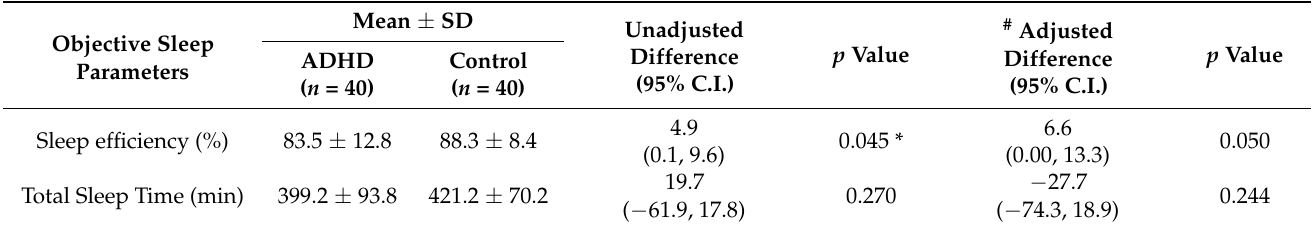
Table 11. Comparison of objective sleep quality parameters between ADHD and control group.